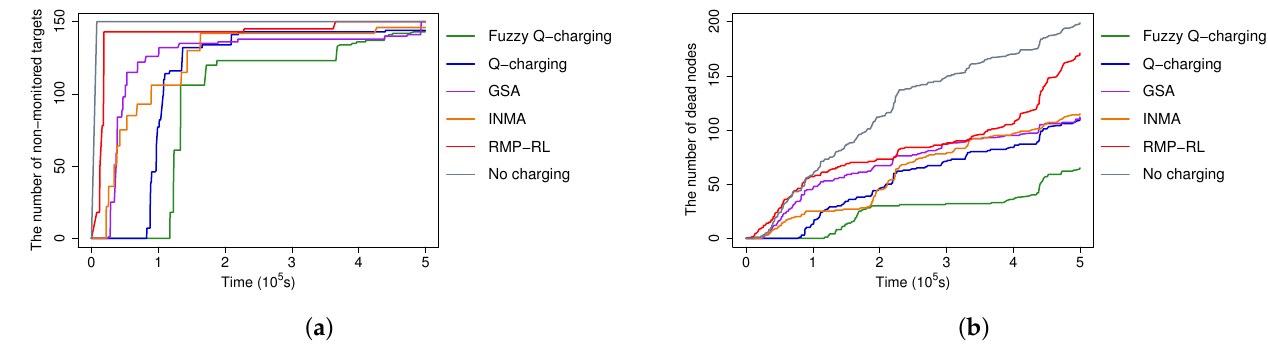
Figure 10. A comparison of non-monitored targets and dead sensors over time. ( a ) Non-monitored targets over time. ( b ) Dead sensors over